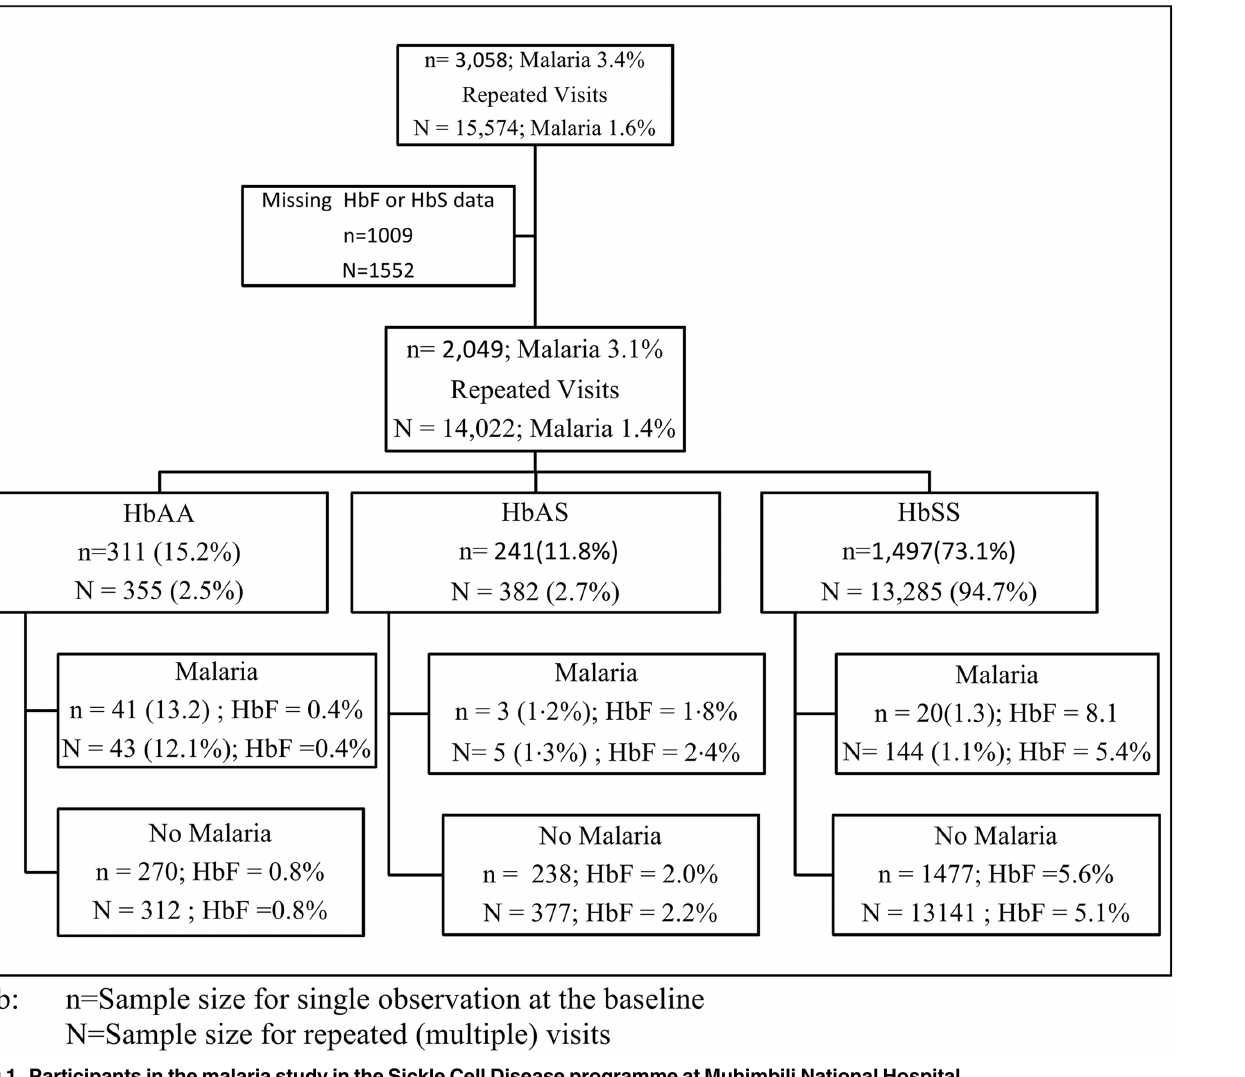
Fig 1. Participants in the malaria study in the Sickle Cell Disease programme at Muhimbili National Hospital.